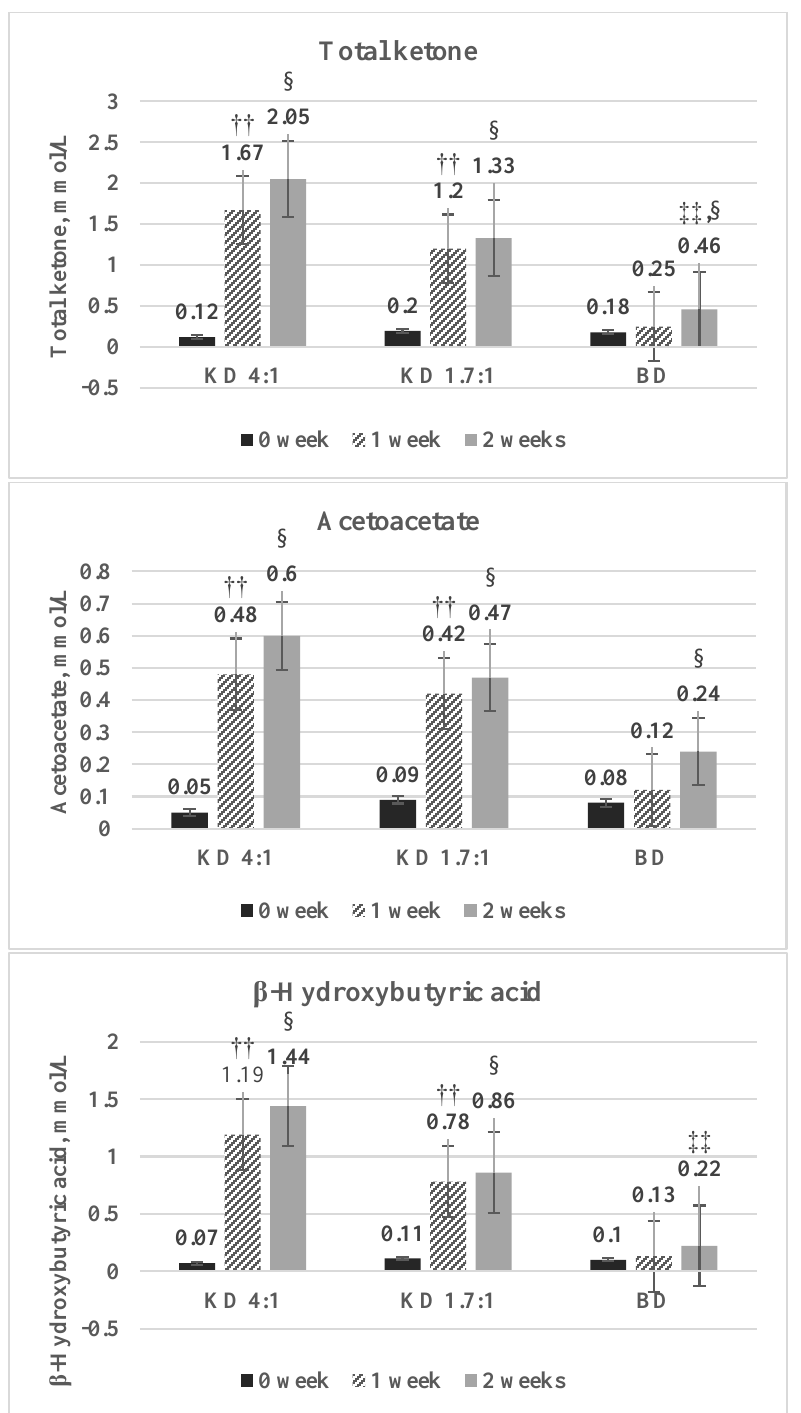
Figure 2. Changes in ketone body biomarkers of each group at 0 week, 1 week, and 2 weeks. †† Significant difference between 0 week and 1 week by Paired t -test, Wilcoxon signed rank test. ‡‡ Significant difference between 1 week and 2 weeks by Paired t -test, Wilcoxon signed rank test. § Significant difference between 0 week and 2 weeks by Paired t -test, Wilcoxon signed rank test.